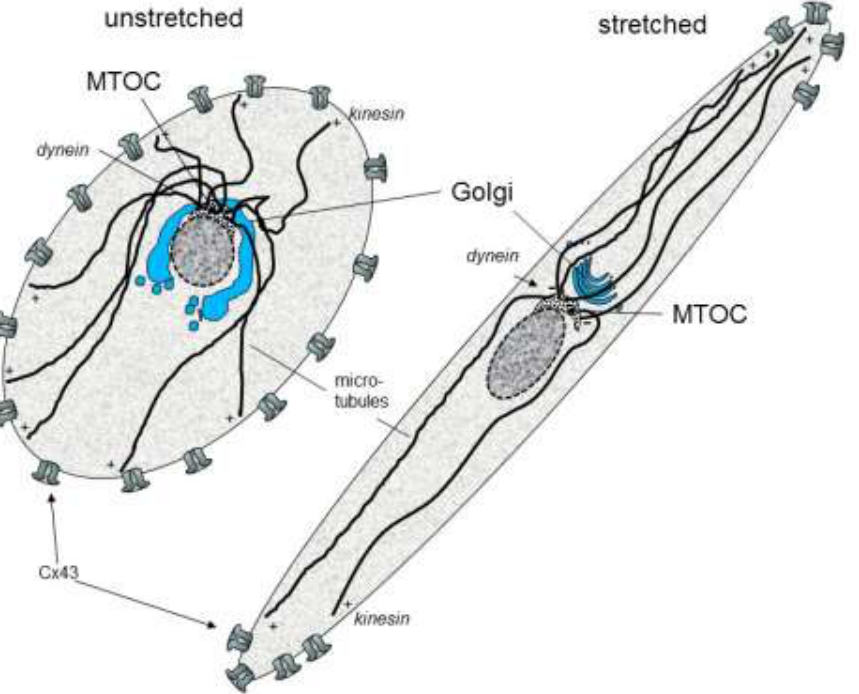
cardiomyocytes (MTOC: microtubule organizing center; Cx: Figure 1. Schematic effects of cyclic stretch on the organization of cytoskeleton and gap junctions in cardiomyocytes. (MTOC: microtubule organizing center; Cx: connexin).